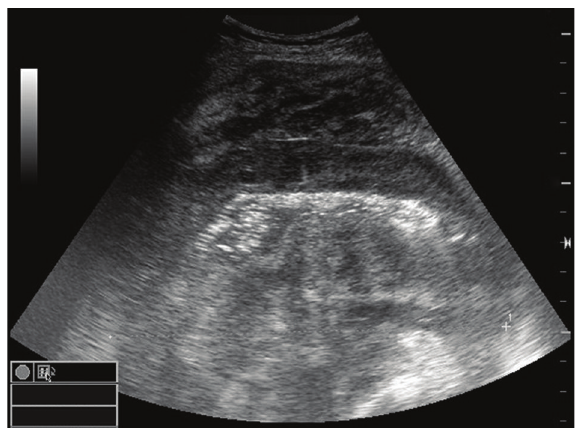
Figure 1: Ultrasonographic image displaying solid areas consistent with thickening of the intestinal wall in the right-lower quadrant.